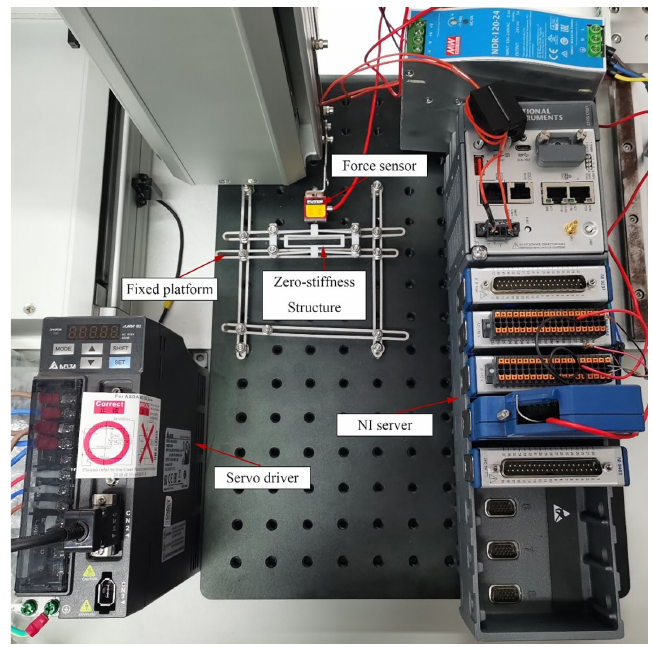
Figure 10. Experimental setup for the complaint constant force mechanisms.